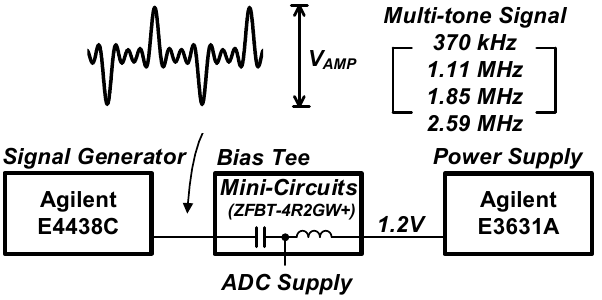
Figure 19. The measured DNL and INL of the SAR ADC with the SCRD.